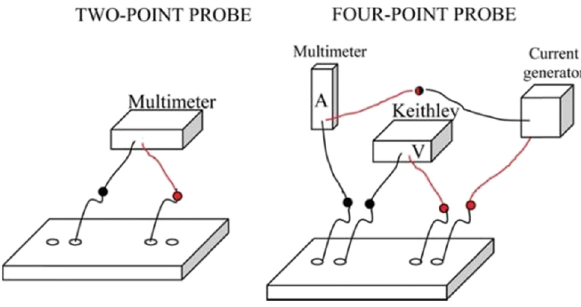
Figure 24: Schematic diagram of two - point and four - point probe test method [ 150 ]